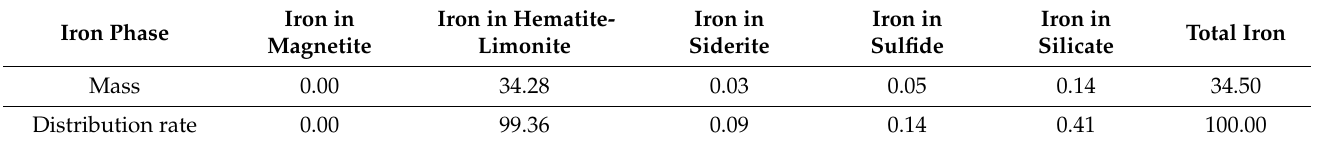
Table 2. Chemical iron phase analysis of the limonite ore (mass, %).